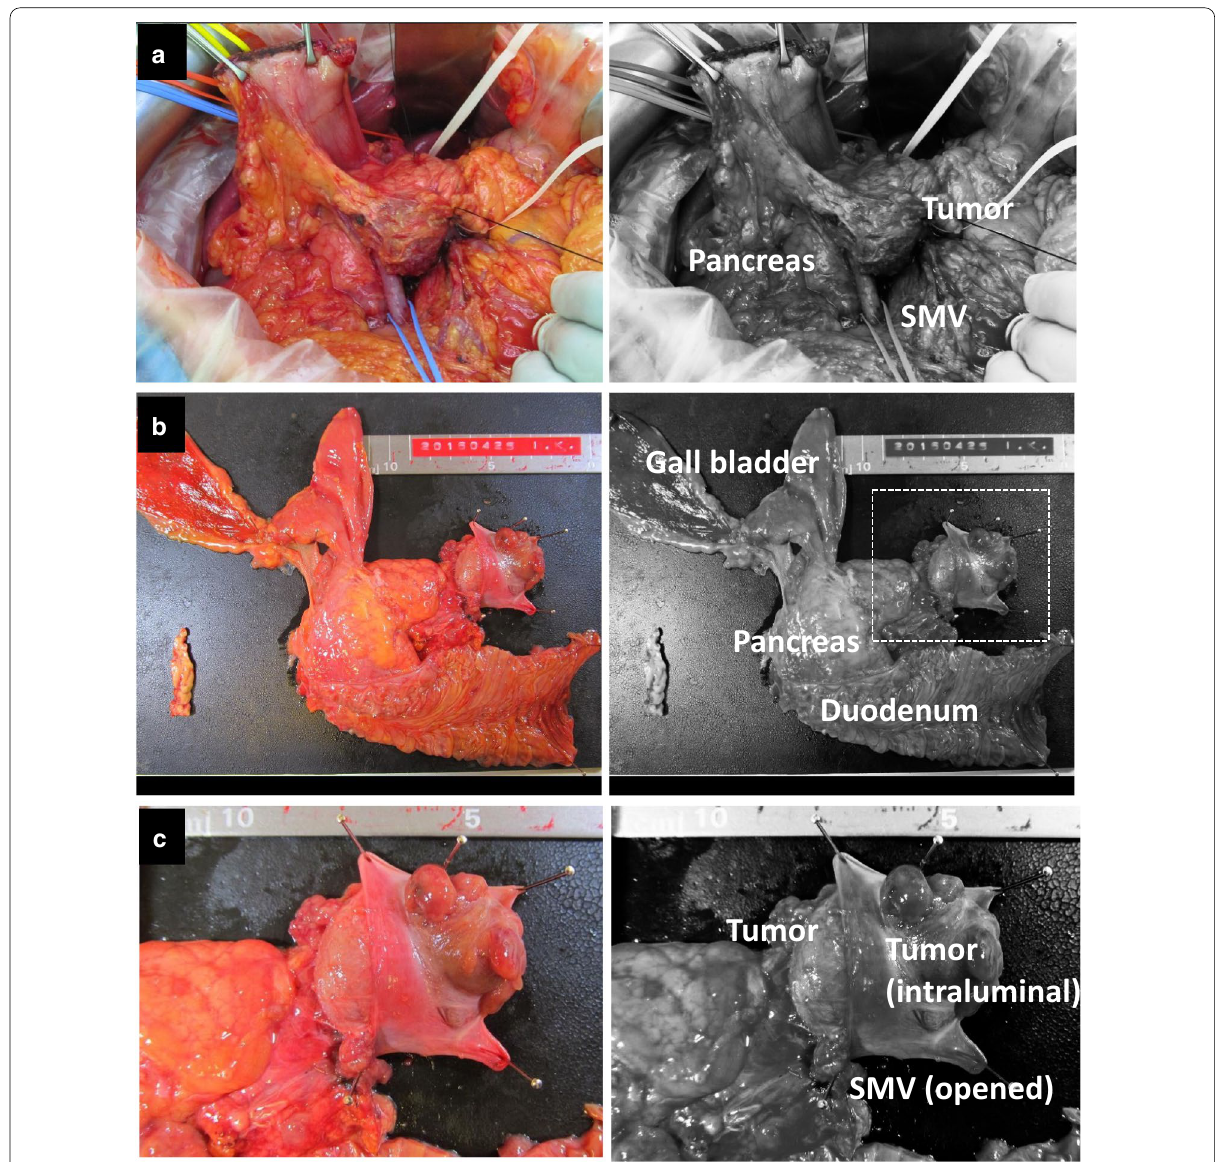
Fig. 4 Gross specimen photographs. a Intraoperative photograph shows the main tumor, the superior mesenteric vein (SMV) and pancreas head. b , c Gross examination of the resected specimen showing a pancreatic tumor invading the